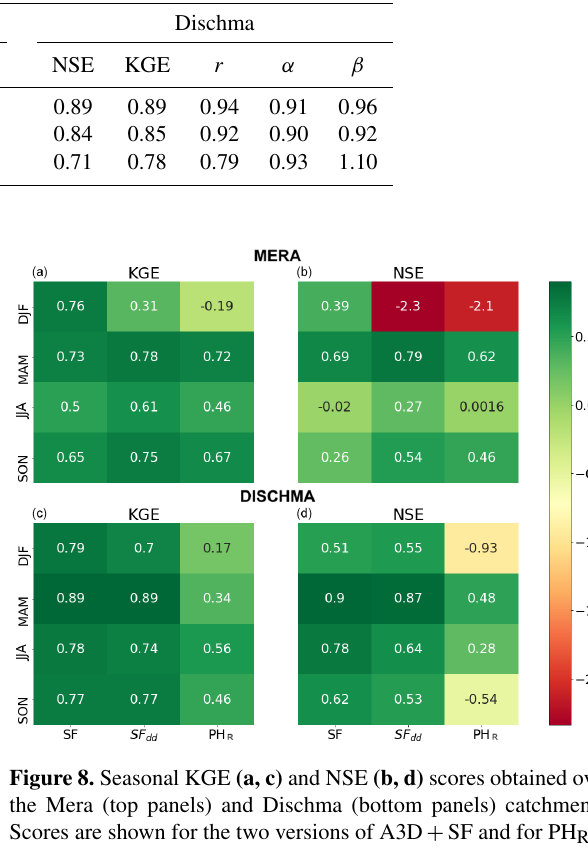
Table 10. Performance scores over the validation period for discharge in the Mera and Dischma catchments, for StreamFlow forced by the full-solver output of Alpine3D (SF), the degree-day melting scheme of Alpine3D (SF dd ) and Poli-Hydro (PH R ). Mera Dischma